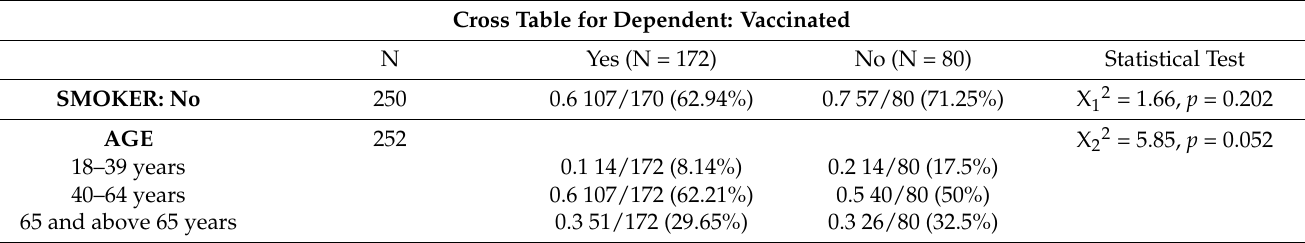
Table 1. Sociodemographic characteristics and decision to vaccinate, in the psychiatric population. Cross Table for Dependent: